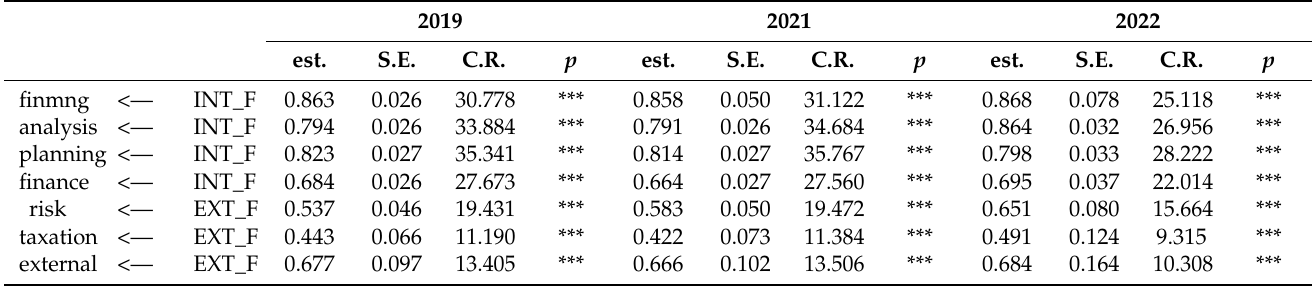
Table 3. Standardized estimates, errors, and reliability of the 2019, 2021, and 2022